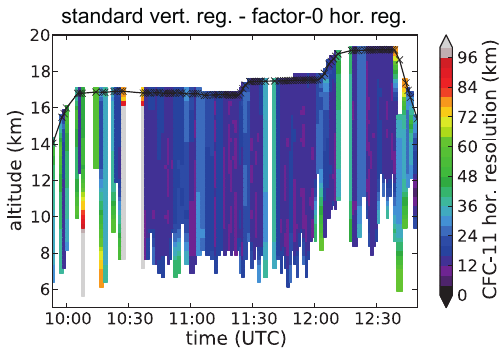
Fig.8. Across-sectionofCFC-11horizontalresolution(FWHM)forthebaselinesetup. Fig. 8. A cross-section of CFC-11 horizontal resolution (FWHM) for the baseline